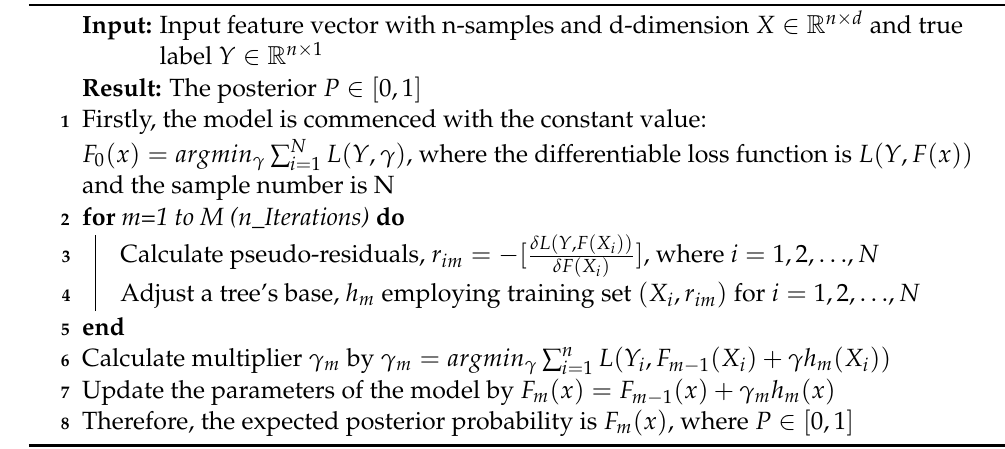
Algorithm 4: The procedure for applying the XGB diabetes detection